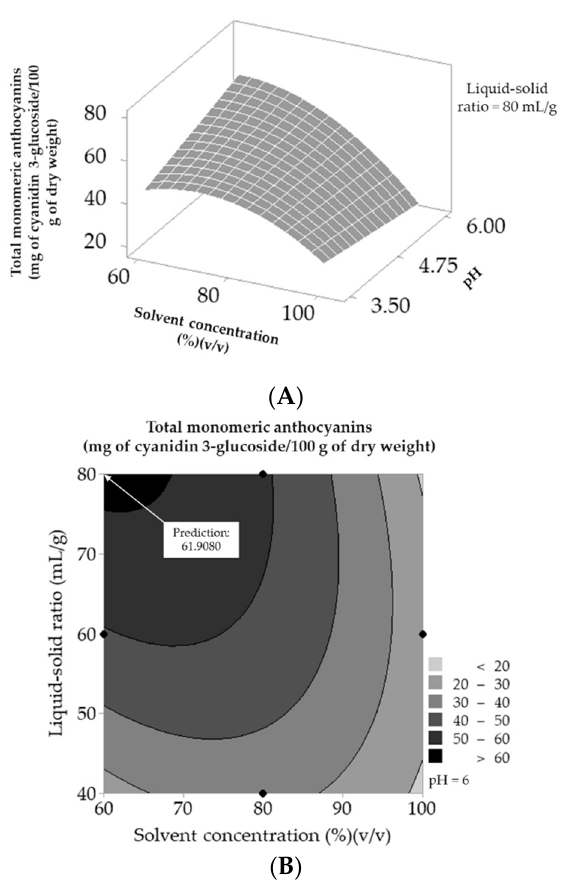
Figure 4. ( A ) Response surface of the model: solvent concentration and pH. ( B ) Optimization response: solvent concentration and liquid–solid